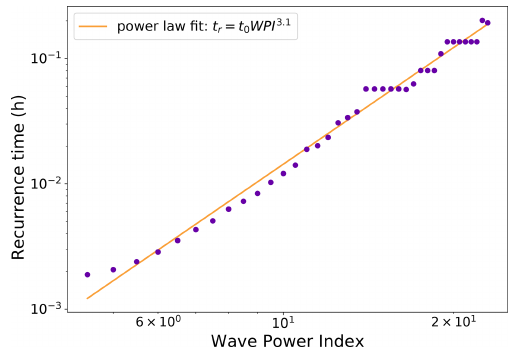
Figure 7. Wave recurrence time for a range of WPI values. The orange line corresponds to a power law fit using non-linear least squares, where t 0 is a scaling factor (10 − 5